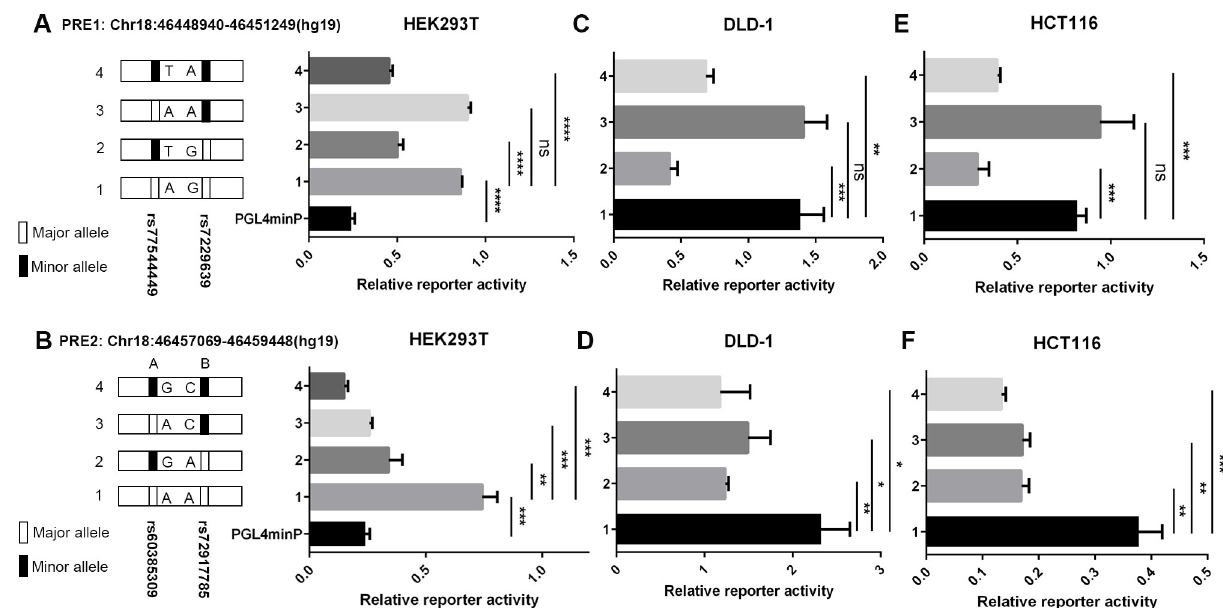
Fig 3. Luciferase reporter assays of two PREs containing candidate functional SNPs. ( A ) Luciferase reporter assays of PRE1 containing rs77544449 and rs7229639 with either the major or minor allele, or empty vector (PGL4minP) were performed in HEK293T cells. ( B ) Luciferase reporter assays of PRE2 containing rs60385309 and rs72917785 with either the major or minor allele, or empty vector (PGL4minP) were performed in HEK293T cells. ( C-F ) Luciferase reporter assays of two PREs containing candidate functional SNPs with either the major or minor allele was measured in DLD-1 cells or HCT116 cells. Two-tailed Student’s t tests were used to calculate P values. Error bars, SD. n = 3. � P < 0.05, �� P < 0.01, ��� P < 0.001, ���� P < 0.0001. ns, not significant.